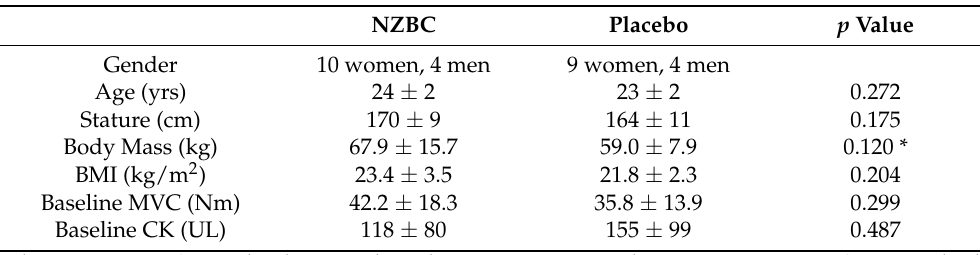
Table 1. Participant characteristics and descriptive statistics between the NZBC ( n = 14) and PLA groups ( n = 13).